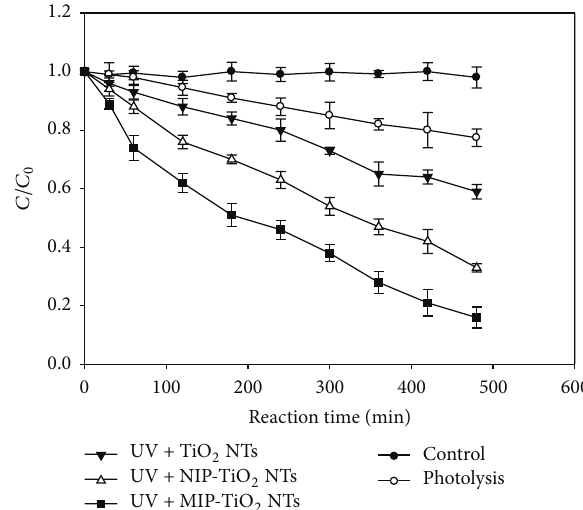
Figure 6: Comparison of PFOA degradation kinetics towards UV photolysis, TiO 2 NTs, NIP-TiO 2 NTs, and MIP-TiO 2 NTs. Initial solution concentration 𝐶 0 and pH are 30mg/L and 5,